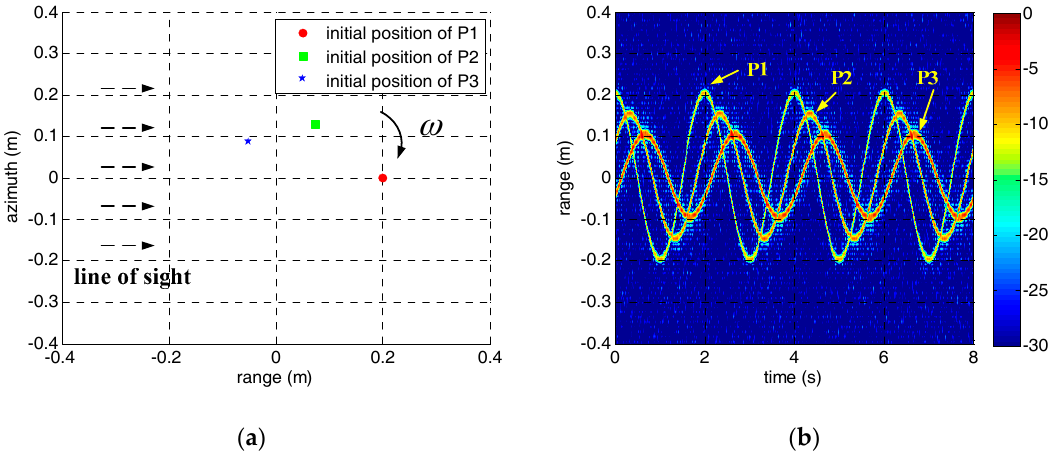
Figure 1. The simulation scenario and the HRRP of the rotating scatterers. ( a ) The initial position of the scatterers. ( b ) The HRRP of the scatterers.